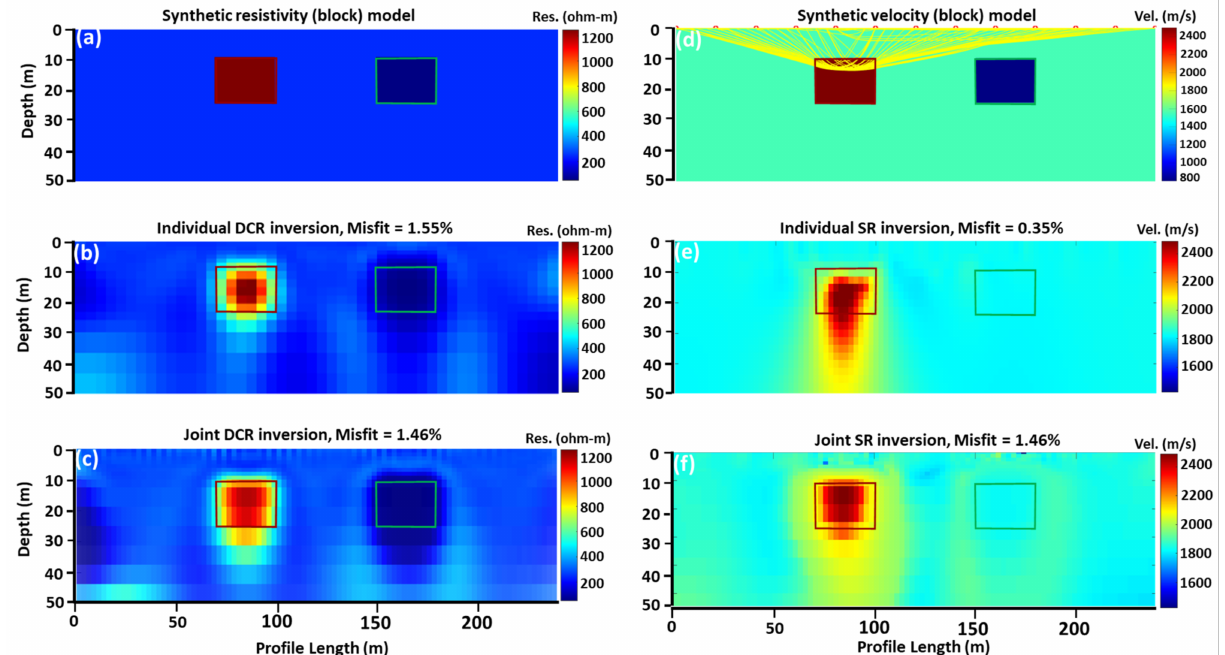
Figure 9. Positive and negative anomaly model inversion using local optimization method; ( a ) synthetic dc-resistivity model, ( b ) individual inverted resistivity model, ( c ) joint inverted re- sistivity model, ( d ) synthetic velocity model and its ray path coverage, ( e ) individual inverted velocity model, and ( f ) joint inverted velocity model. The dark red and green lines are used to mark the anomaly boundary.